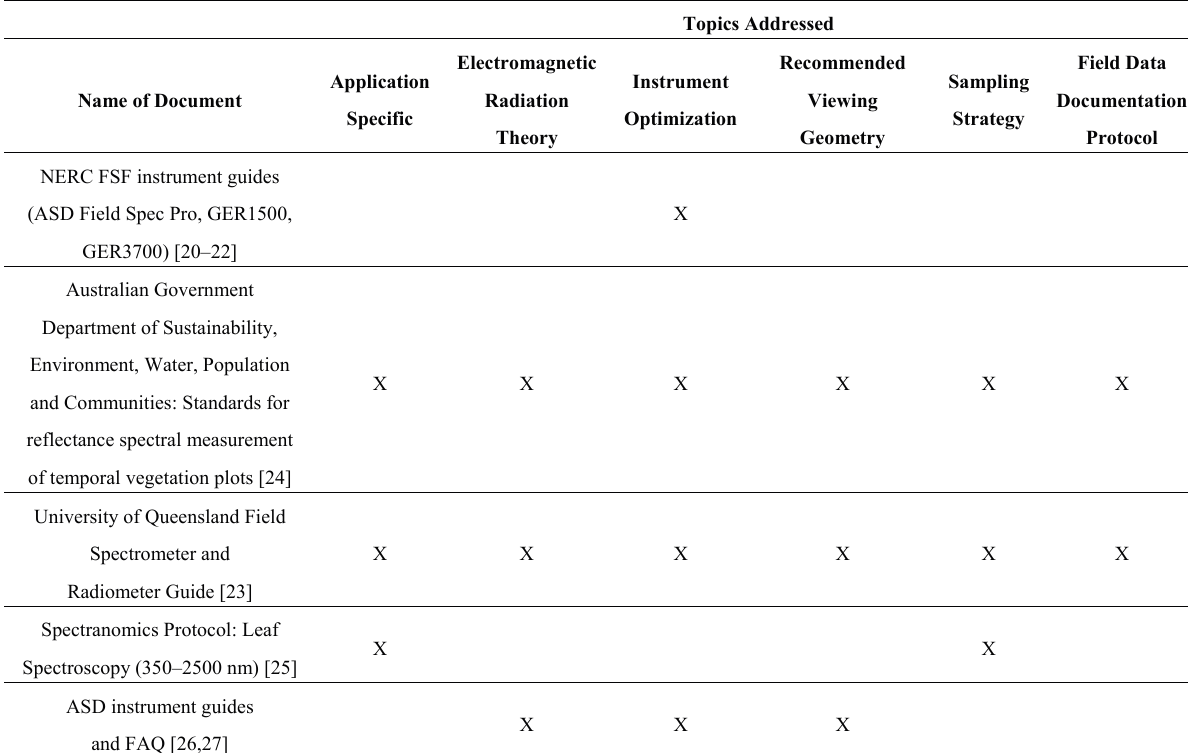
Table 1. Comparison of a sample of field spectroscopy good practice